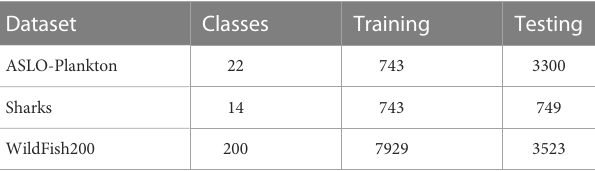
TABLE 1 Statistics of ASLO-Plankton, Sharks and WildFish200 datasets.